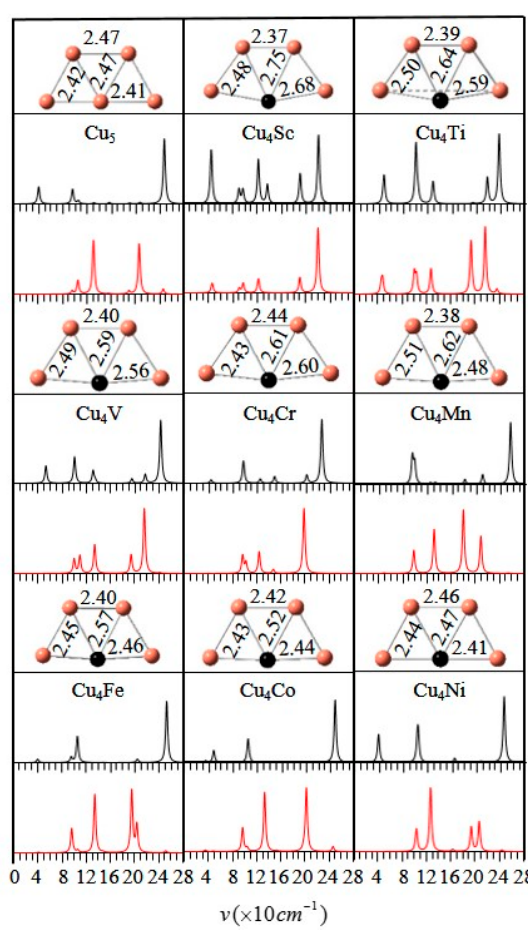
Figure 2. Vibrational (black) and Raman (red) spectra of the ground state Cu 4 M (M = Sc-Cu) clusters.